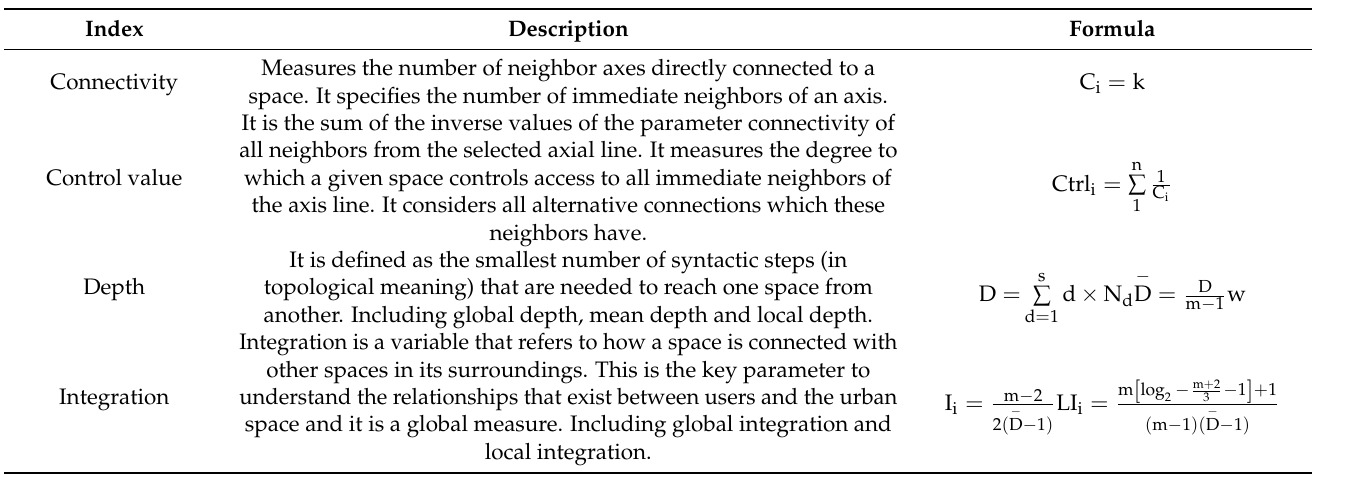
Table 2. Basic measures of spatial